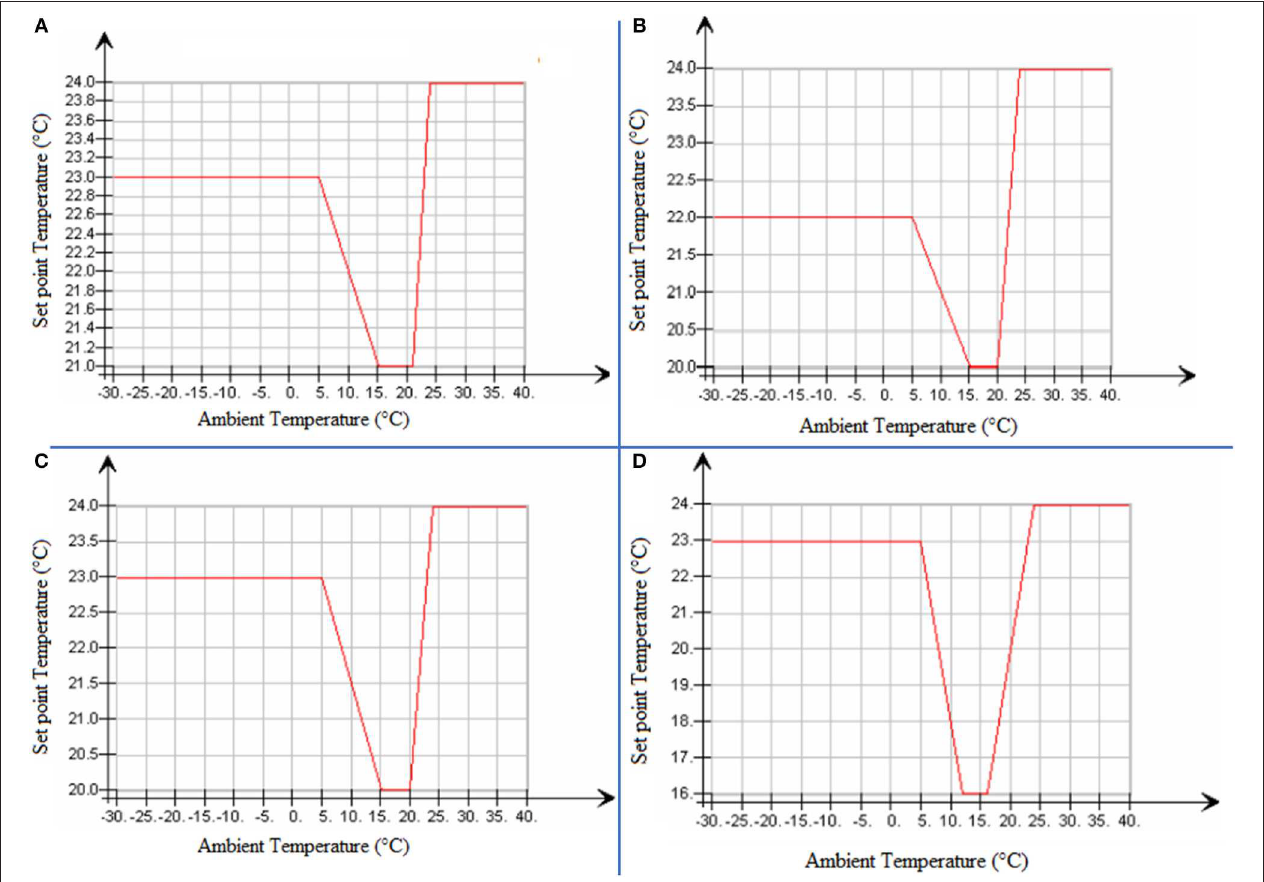
FIGURE 6 | Hybrid 3, Set point temperature for: the occupied zones using the opening areas between the ones and the Light Well as VAV cooling actuator. (A) The light well using the areas between the light well and the Sub-floor Plenum as actuator. (B) For the Sub-floor Plenum using the areas between the Sub-floor Plenum and the outdoor as actuator during unoccupied (C) and occupied (D)